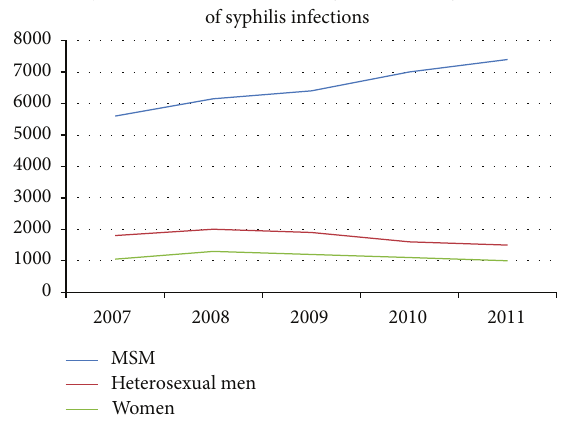
Figure 2: Syphilis—Reported Cases by Stage of Infection, United States, 1941–2011. Centers for Disease Control and Prevention. STD Trends in the United States 2012 . Atlanta: U.S. Department of Health and Human Services;